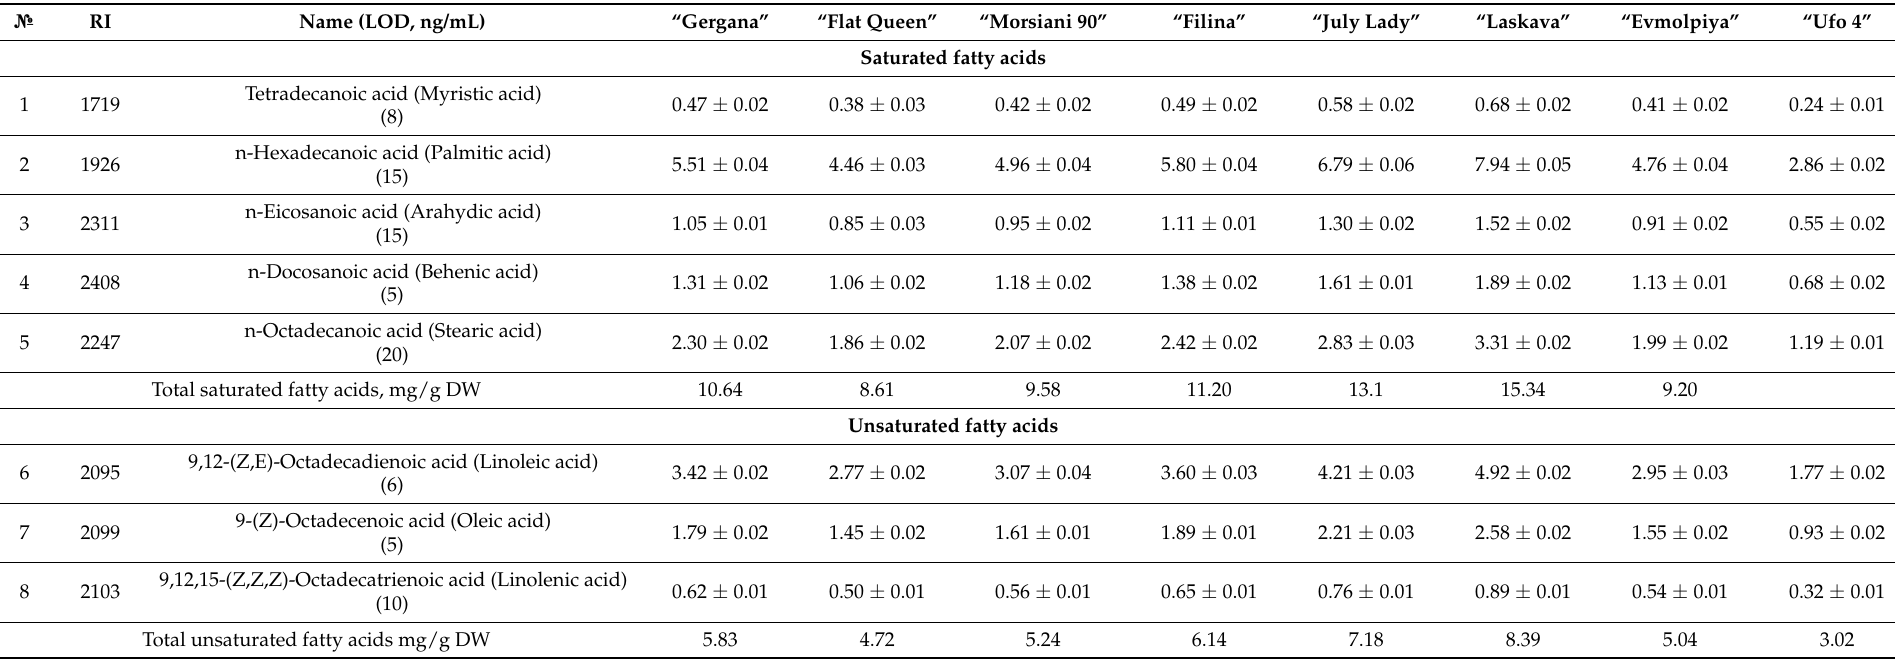
Table 3. Metabolites identified (mg/g DW) in the nonpolar fraction of peach ( Prunus persica L.)